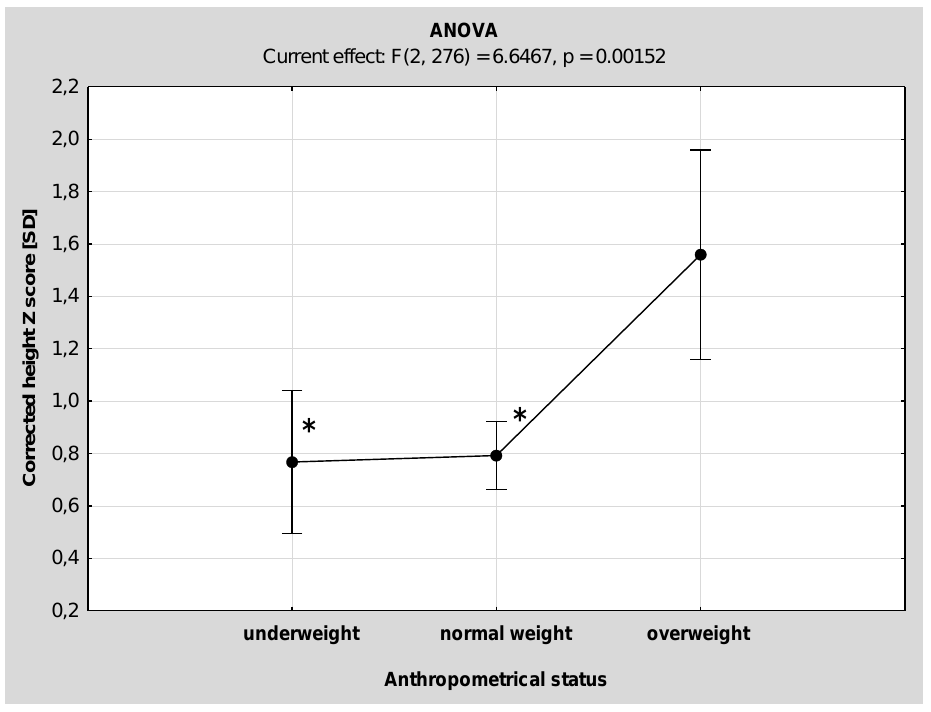
Figure 2. Comparison of corrected height z -score among the anthropometrical subgroups by one-way analysis of variance (ANOVA). * p < 0.01 vs. overweight subgroup.